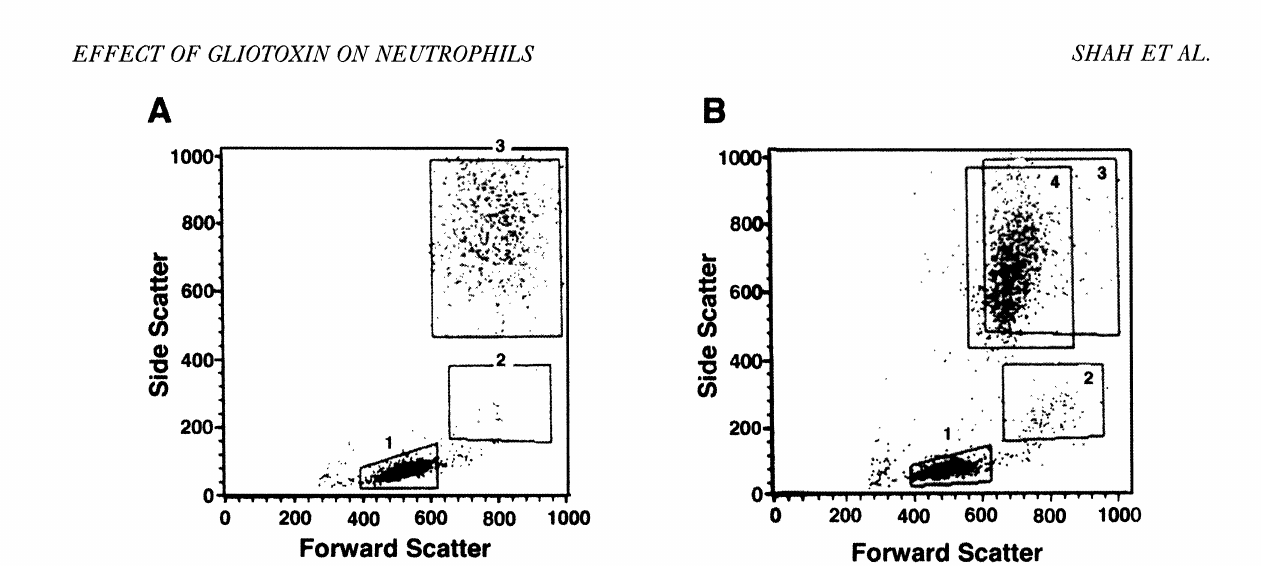
Fig. I. Flow cytometric analysis of human blood leukocytes. Flow cytometric analysis of peripheral blood collected from healthy donors was performed in a FACscan flow cytometer. (A) Windows I, 2, and 3 represent lymphocytes, monocytes, and PMN. The leukocyte populations are separated on the basis of forward vs side scatter. (B) Human leukocytes exposed to 500 pg/mL-concentration of gliotoxin for 30 minutes showed a shift in PMN population from right to left on the forward scatter axis and downward on the side scatter scale, consistent with these cells becoming smaller and less